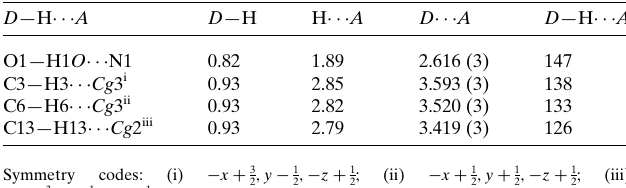
Table 1 Hydrogen-bond geometry (A˚ , (cid:3) ) for (I). Cg 2 and Cg 3 are the centroids of rings C8–C13 and C15–C20, respectively.